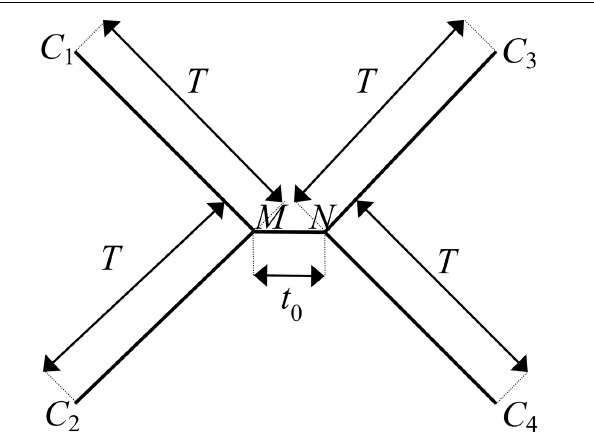
FIGURE 2 | The canonical phylogenetic quartet in an ultrametric form, with an internode of length t o and four subtending branches of equal length T . The ancestral character states at the two ends of the internode are denoted as M and N . The character states at the terminal leaves of the four branches are denoted as C 1 , C 2 , C 3 , and C 4 . The pattern of character states at a site consistent with the true topology of the four-taxon tree, τ 3 , is C 1 = C 2 , C 3 = C 4 , C 1 (cid:3)= C 3 . A site pattern that matches C 1 = C 3 , C 2 = C 4 , C 1 (cid:3)= C 2 or C 1 = C 4 , C 2 = C 3 , C 1 (cid:3)= C 2 is consistent with one of the two possible incorrect subtrees of the four-taxon tree: τ 1 or τ 2